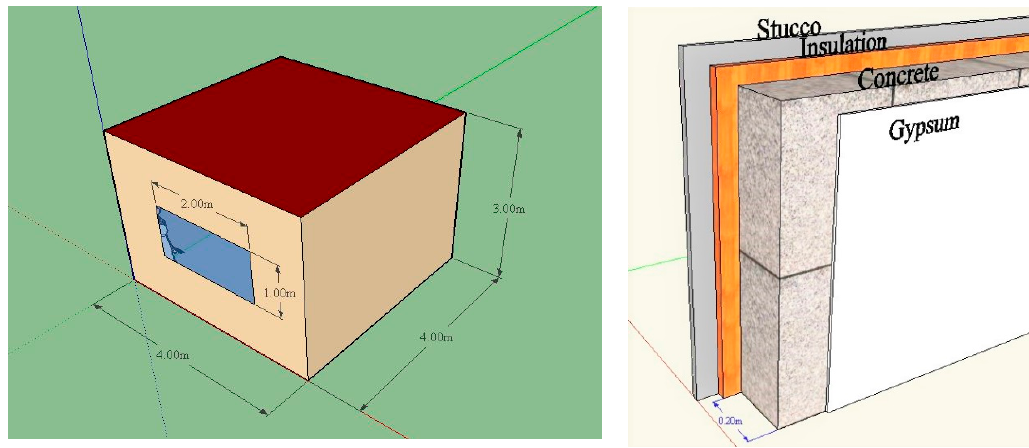
Figure 2. The building geometry and materials. Table 3. The basic information for building geometry.